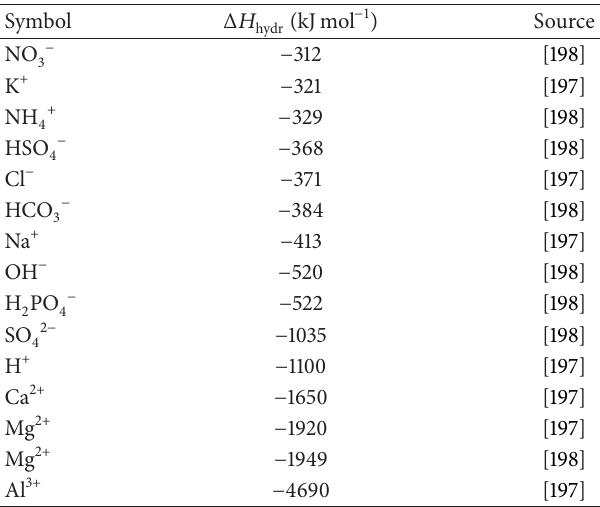
Table 5: Selected hydration enthalpies of common biologically relevant ions